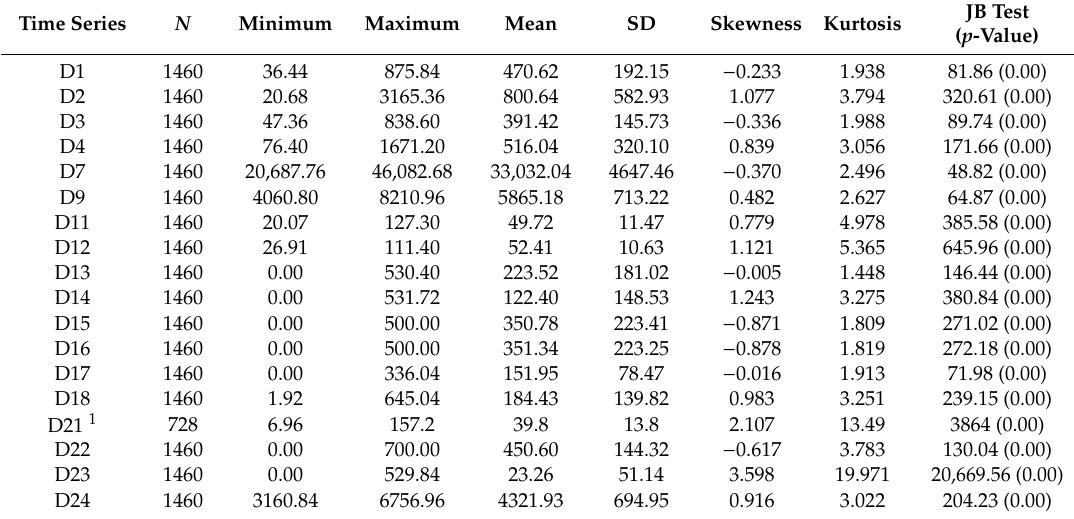
Table 7. Summary